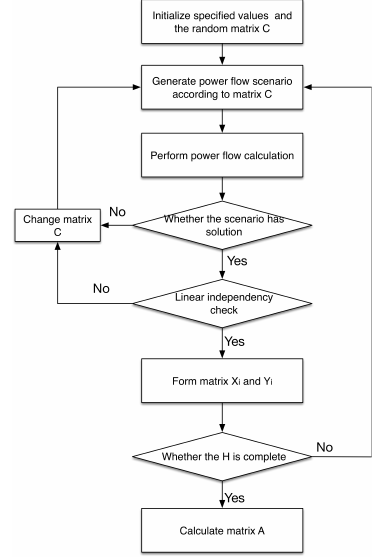
Figure 14. Workflow of matrix A calculation.